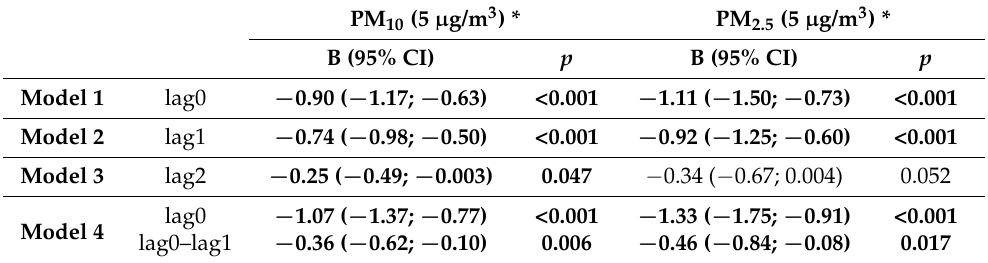
Table 2. Effect of PM 10 and PM 2.5 levels on the evening peak expiratory flow